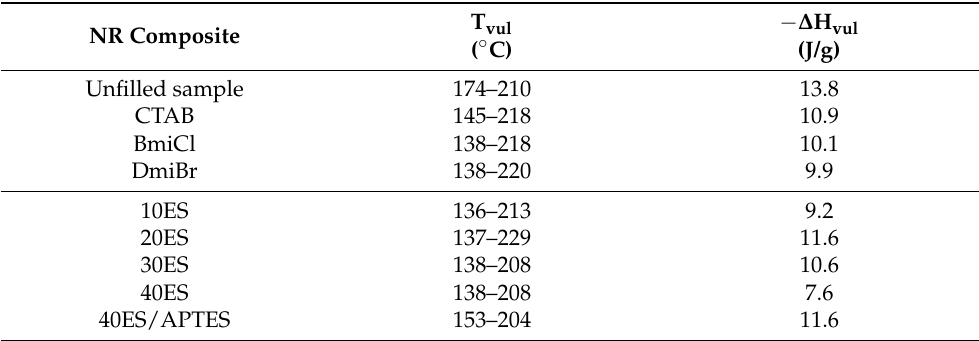
Table 5. Vulcanization temperature (T vul ) and enthalpy ( ∆ H vul ) of NR composites examined by